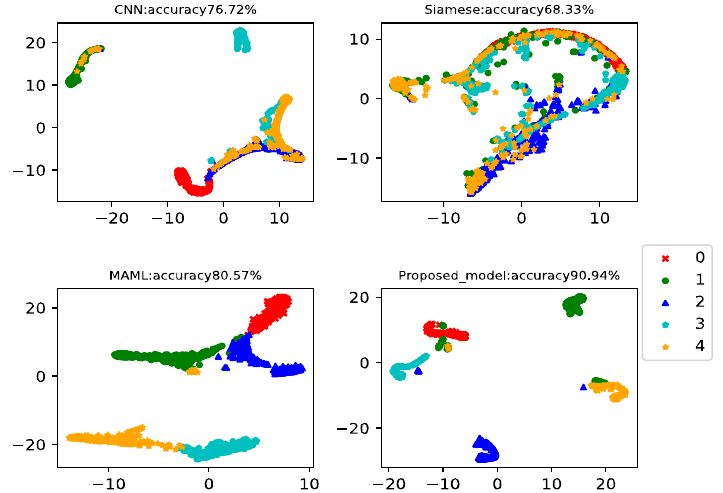
Figure 12. Five-way-five-shot diagnosis of the wind turbine gearboxes using different algorithms.